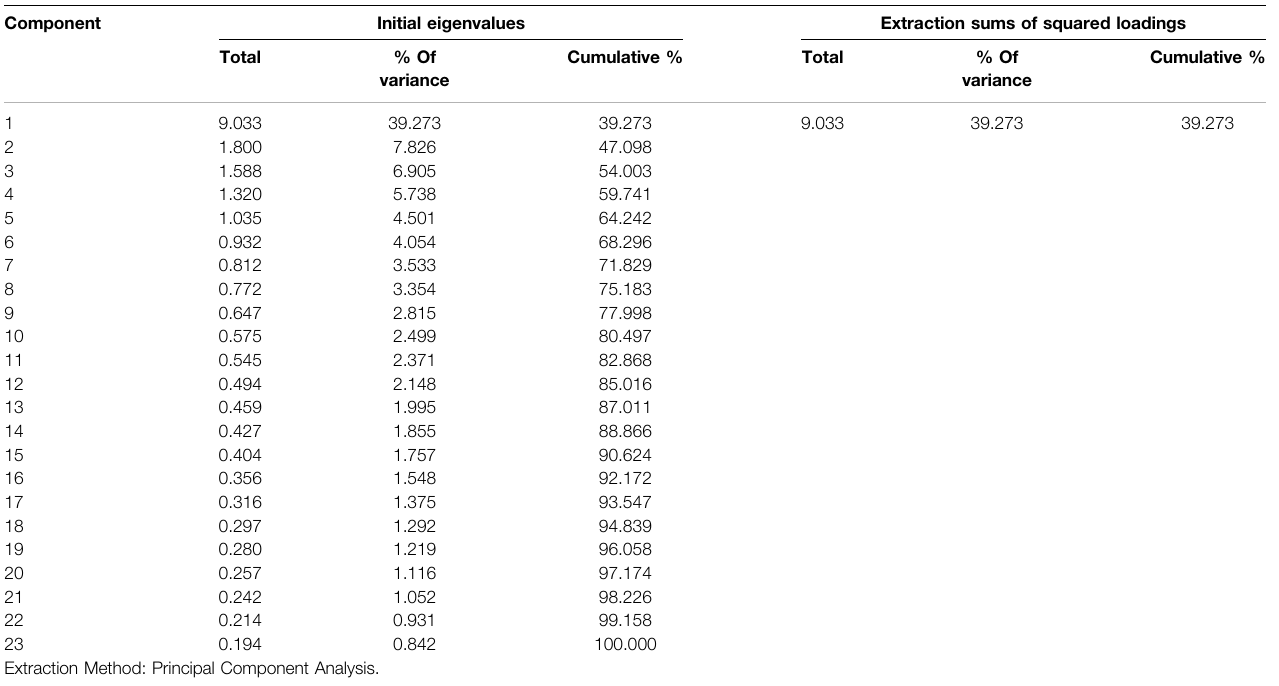
Extraction Method: Principal Component